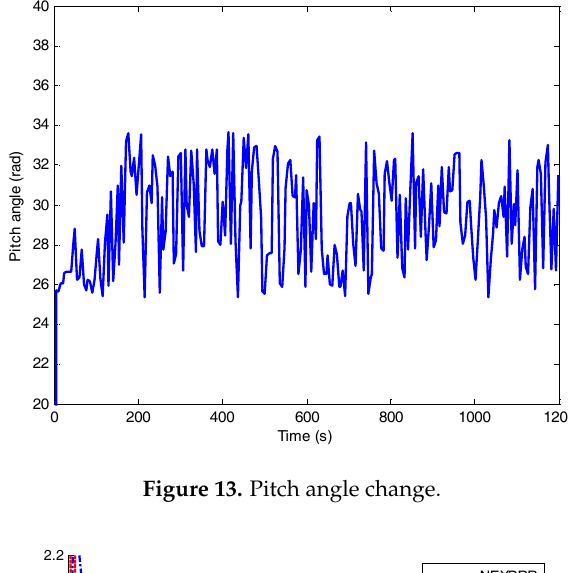
Figure 13. Pitch angle change. Energies 2017 , 10 , 1626